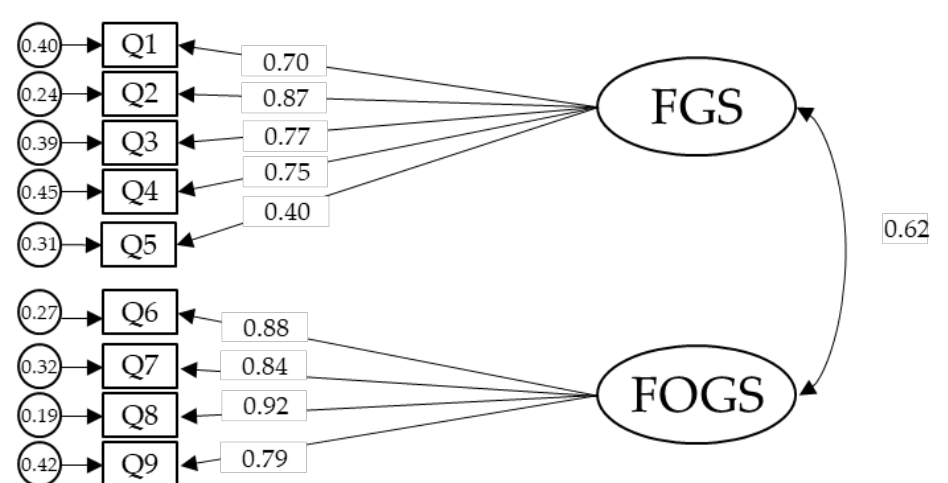
Figure 2. CFA for FIVE proposed two factors. Note: the ellipses represent the factors and the rectangles represent the different items. The residual variances are shown in the small circles. Fears of Getting Sick (FGS), Fears that Others Get Sick (FOGS).